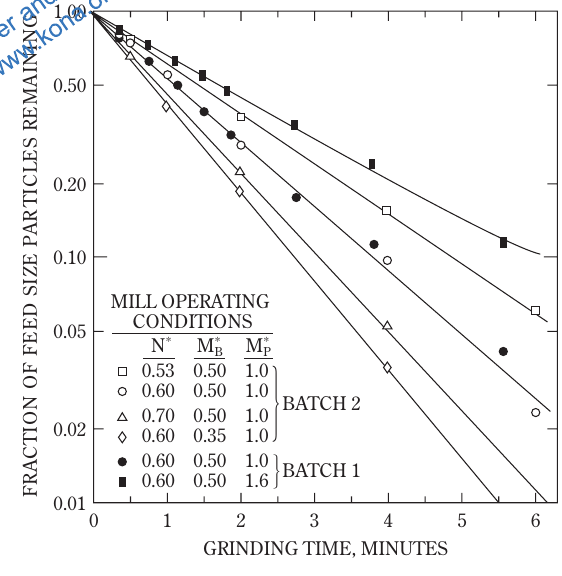
Fig. 1 The influence of mill operating variables on the kinetics of disappearance of 7 (cid:4) 9 mesh dolomite in dry batch ball milling.